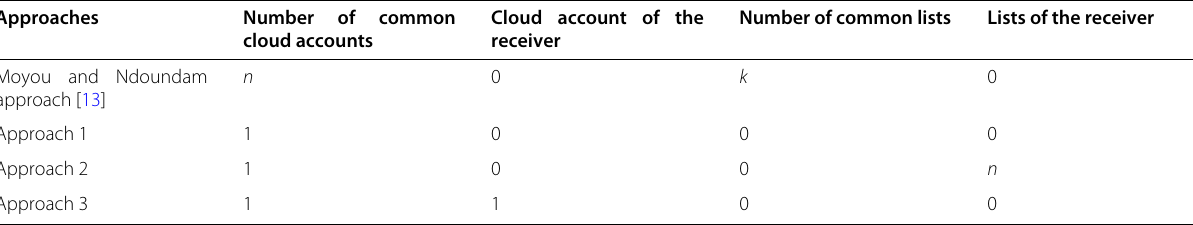
Table 9 Comparison of our approaches and Moyou and ndoundam’s approach based on the number of elements of the key and the elements of the